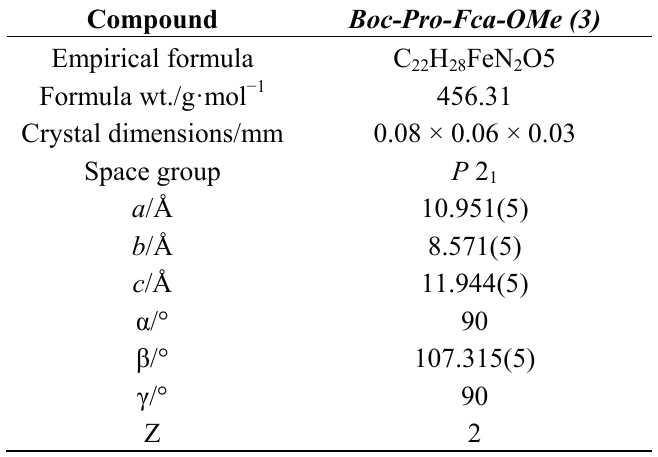
Table 7. Crystallographic, data collection and structure refinement